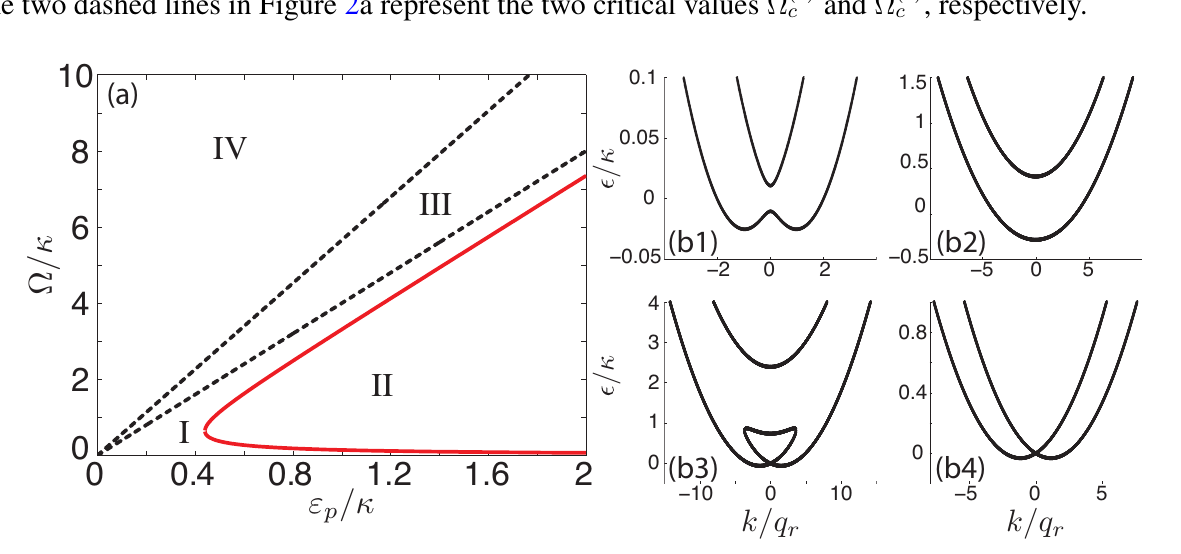
The two dashed lines in Figure 2a represent the two critical values Ω (1)